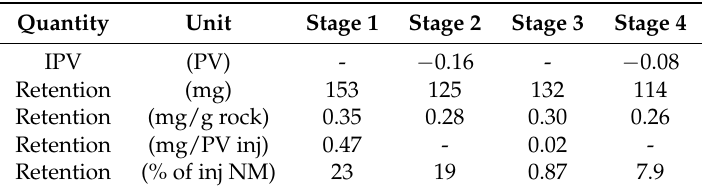
Table 9. IPV and retention of nanomaterials during Experiment